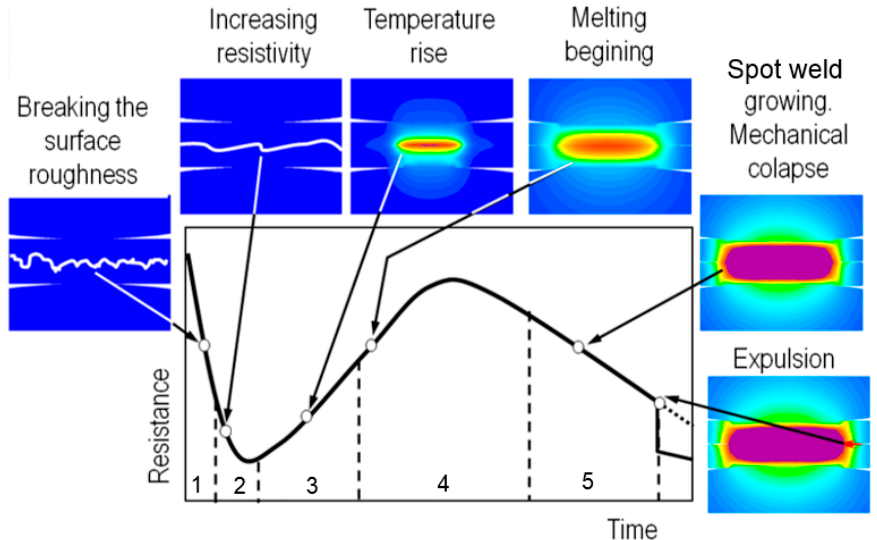
Figure 2. The five stages (1-5) of the behavior and correlation between dynamic resistance and the formation of the weld spot, referring to the resistance spot welding process (RSW). Adapted from Reference [19].